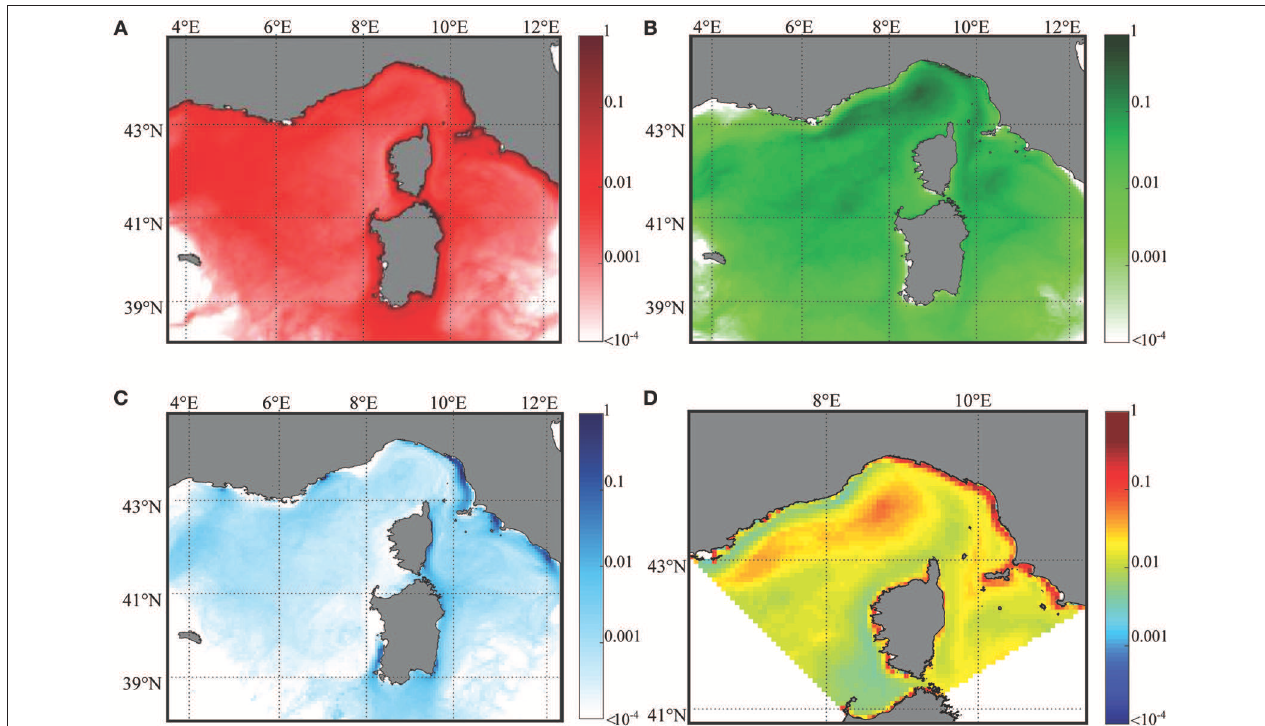
FIGURE 3 | Maps of summer plastic density (hazard component) averaged over the period 2000–2010 from each source of release: (A) coasts, (B) ships and (C) rivers. (D) Overall decennial hazard map in the Pelagos Sanctuary, obtained with a weighted